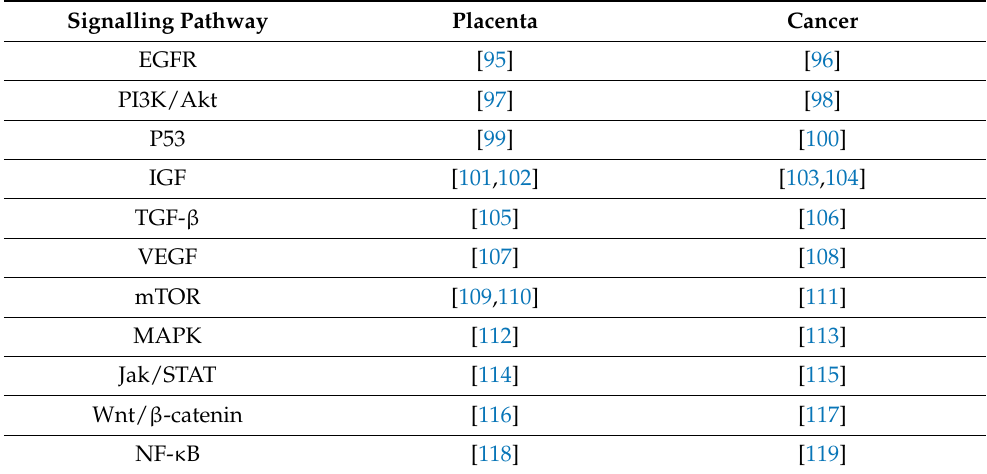
Table 2. Key signalling pathways common to placental development and cancer, with